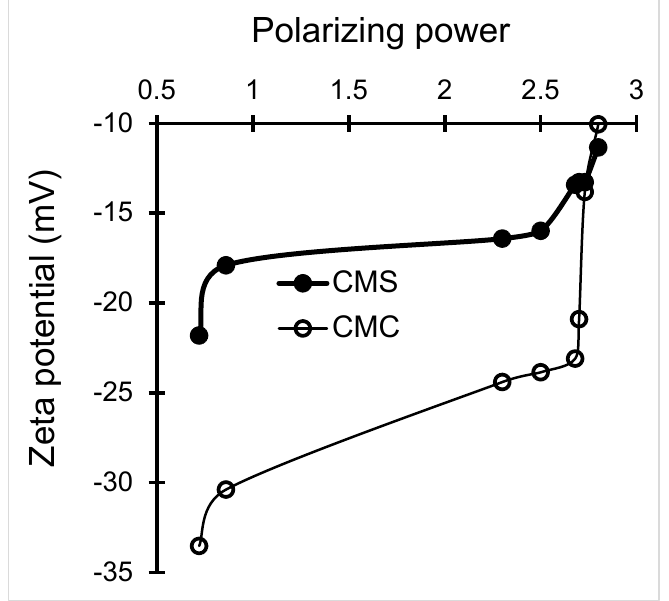
Figure 1. Influence of the polarizing power of the incorporated metal cation on the Zeta potential of metal-loaded CMC and CMS. The Zeta potential was measured for aqueous suspensions of CMC and CMS treated with aqueous solutions of different metal cations (Cu 2+ , Ag + , Zn 2+ , Co 2+ , Pt 2+ , Ti 2+ or Au + ).